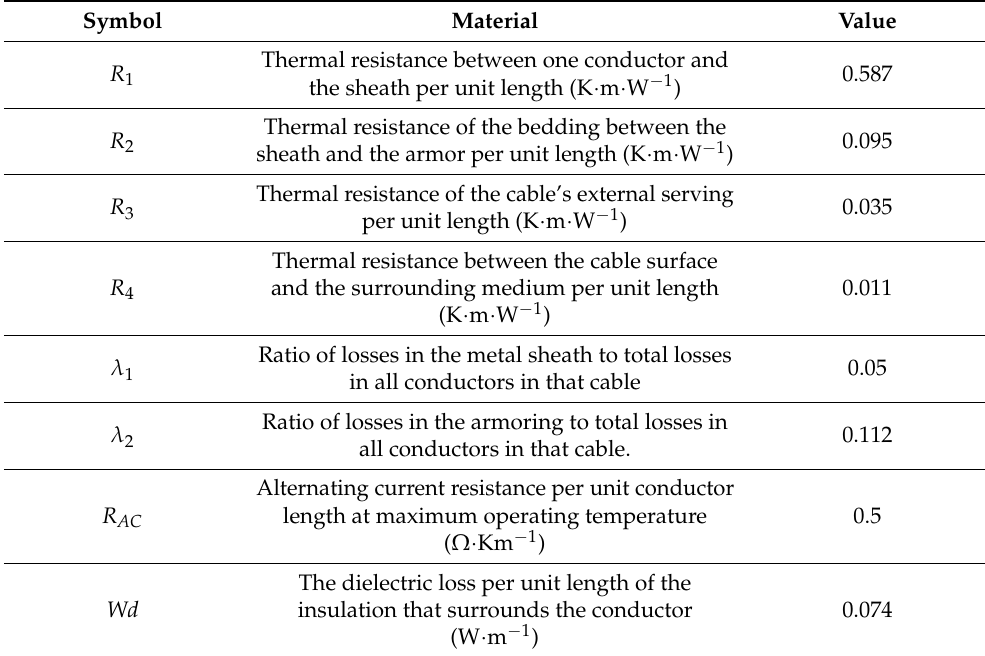
Table 8. Thermal resistances and heat losses in the submarine power